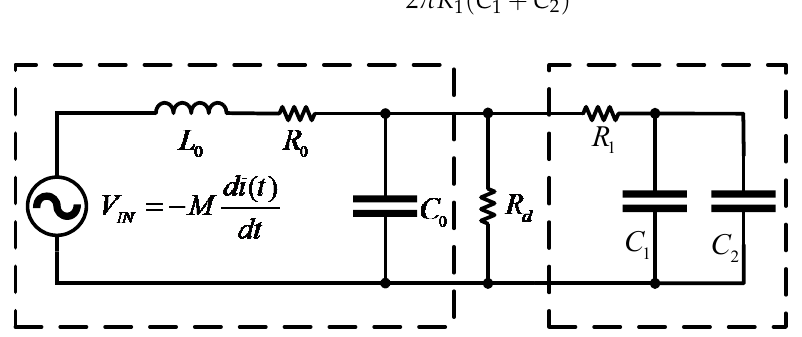
Figure 16. Integrated circuit of the open high-frequency Rogowski coil current sensor. The high-frequency signal above 116 kHz can be